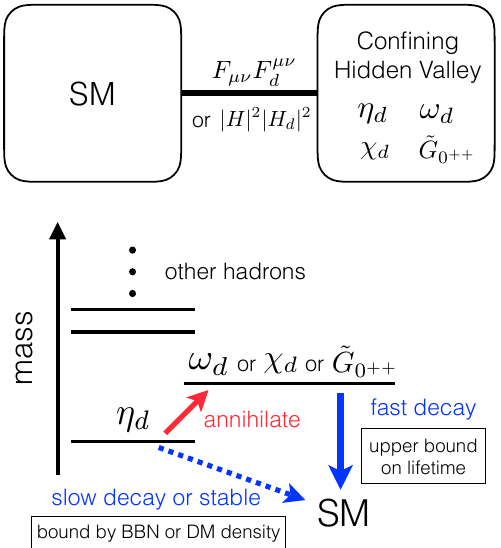
Figure 1 . Left: the CHV scenarios studied in this work. The hidden sector couples to the SM sector either through the photon mixing or the Higgs portal coupling. The pseudo-scalar meson (cid:17) d is the lightest particle in the dark con(cid:12)ning phase. The lightest vector meson ! d , the lightest scalar meson (cid:31) d , and the dark glueball e G play important roles in determining the dark hadron 0 ++ relic abundance. Right: the process that reduces the (cid:17) d energy. (cid:17) d annihilates into heavier hadrons when the hidden sector temperature is comparable to the hadron mass splitting, and ! d ( (cid:31) d or e G 0 ++ ) decay quickly into SM particles through the photon (Higgs) portal coupling comparing to the Hubble time scale while the (cid:17) d conversion is allowed. The remaining (cid:17) d either decays into SM during the BBN/CMB time (photon mixing scenario), or becomes stable DM (Higgs portal scenario). The cosmological constraints on the (cid:17) d abundance set upper bounds on the lifetime of ! d , (cid:31) d , or e G 0 ++